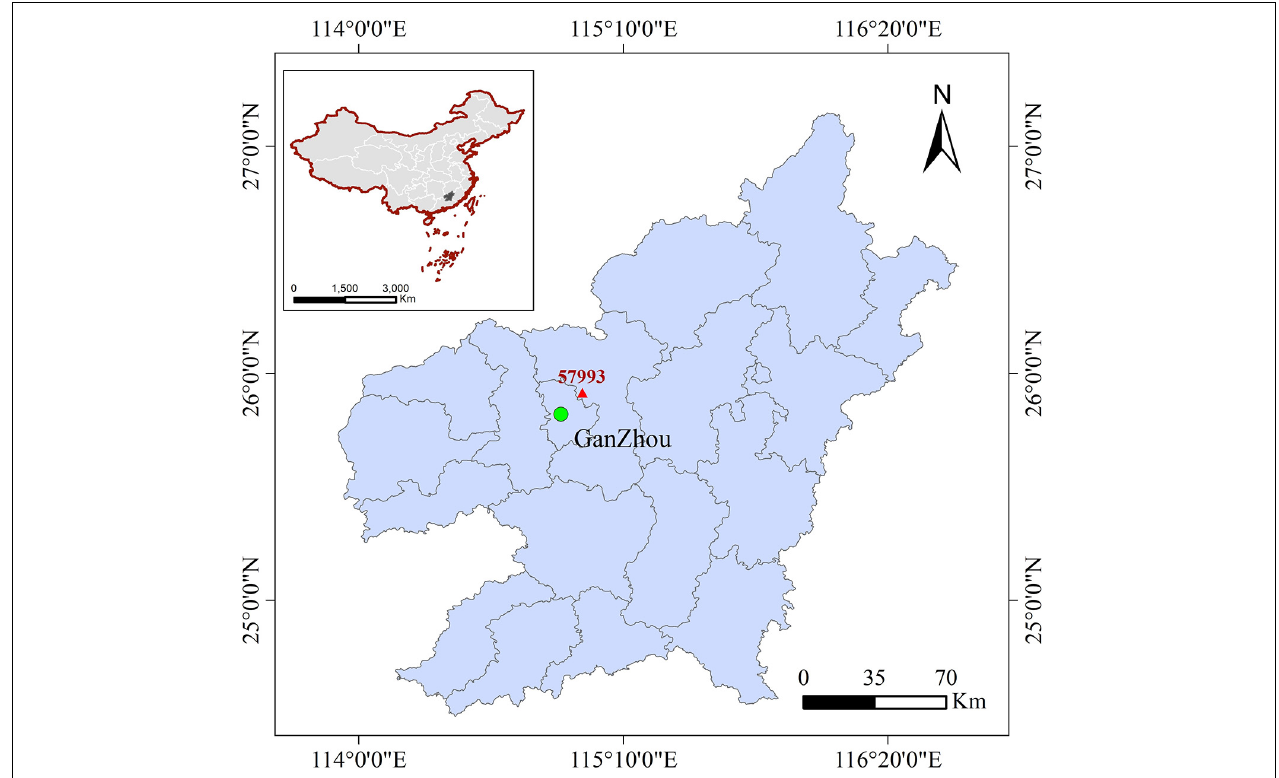
FIGURE 1 | The geographical location of solar radiation monitoring station in Ganzhou County (red